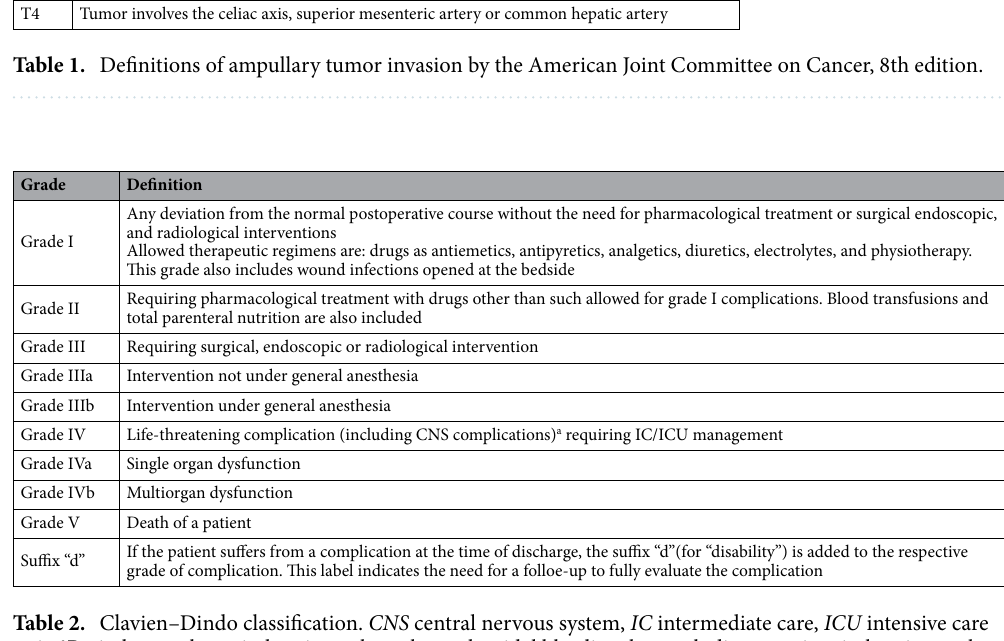
Table 2. Clavien–Dindo classification. CNS central nervous system, IC intermediate care, ICU intensive care unit. a Brain hemorrhage, ischemic stroke, subarrachnoidal bleeding, but excluding transient ischemic